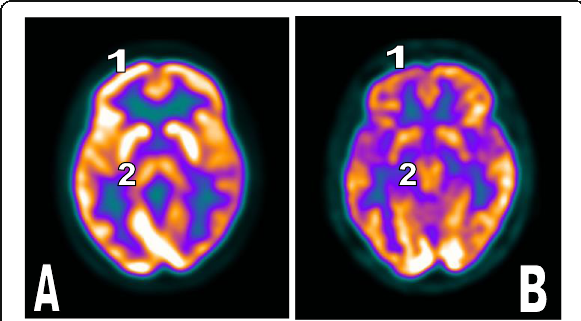
Fig. 3 Fifty-nine-year-old female discovered to have lacrimal gland neoplasm by prior CT, the patient came for PET/CT assessment. Axial fused PET/CT images of the brain before and after chemotherapy. Fused axial PET/CT images show reduced FDG uptake in the post chemotherapeutic state (image b ) compared to the pre- chemotherapeutic state (image a ) along the right frontal lobes {1} (SUVmean 11.3 compared to 20) and along the right basal ganglia regions {2} (SUVmean 12.4 compared to